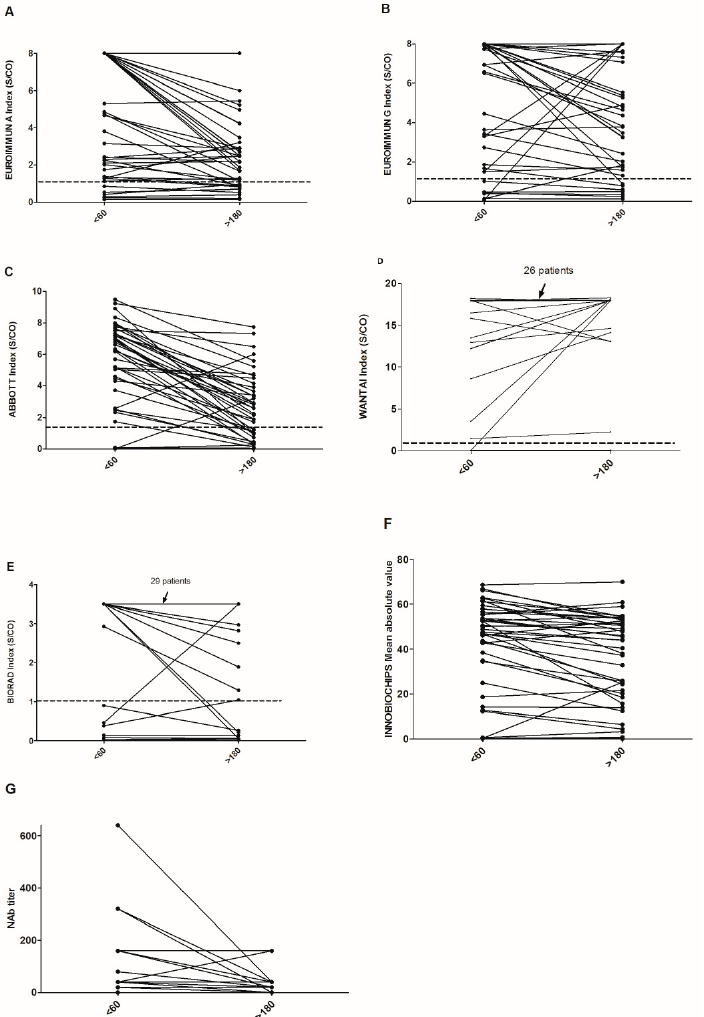
Figure 2. Kinetics of the raw results of the various assays ( A – G ) by comparing the values before Day 60 and after Day 180 post-PCR. The positivity threshold for each assay is indicated by a dotted line.